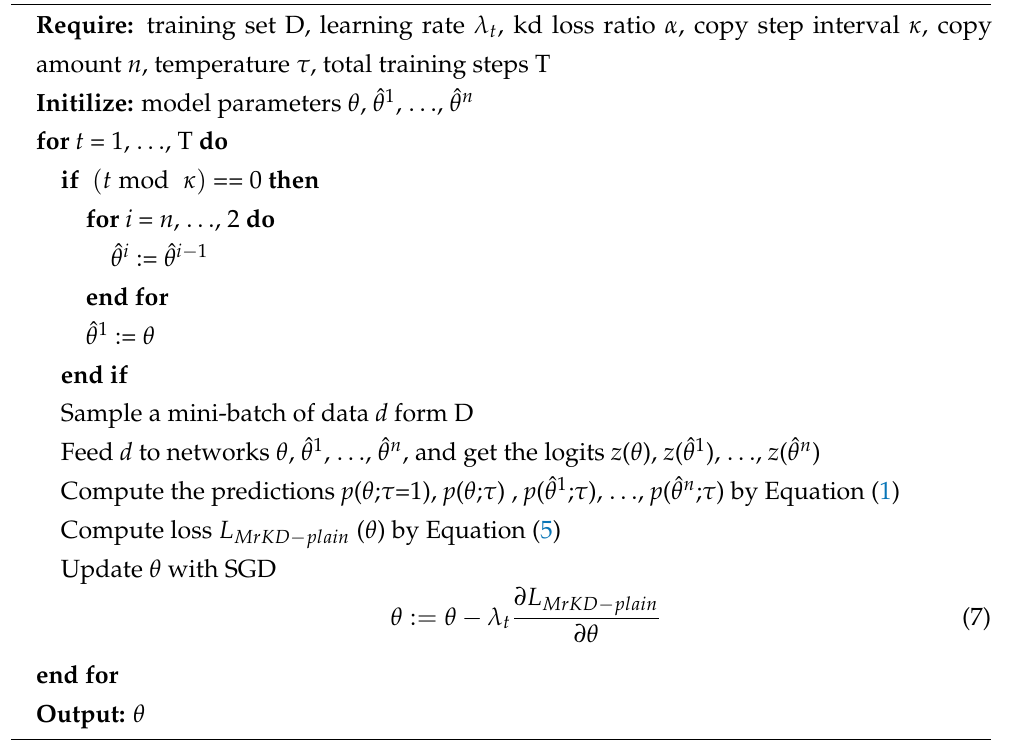
Algorithm 1 Self-Knowledge Distillation with Historical